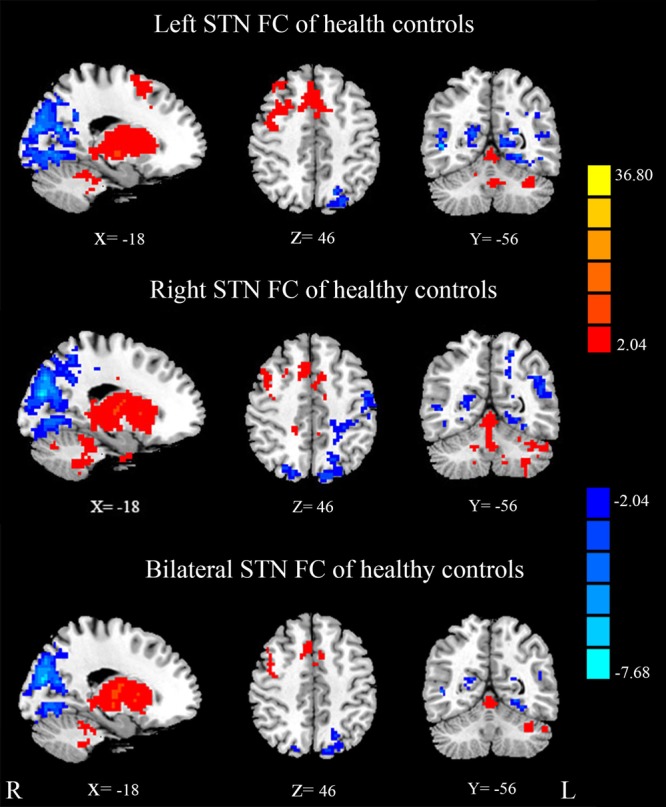
Mean resting state functional connectivity (FC) z-score maps of the STN in healthy controls. STN FC map of healthy controls, results are in MNI space, red color represents the positive correlation while the blue color represents the negative correlation.